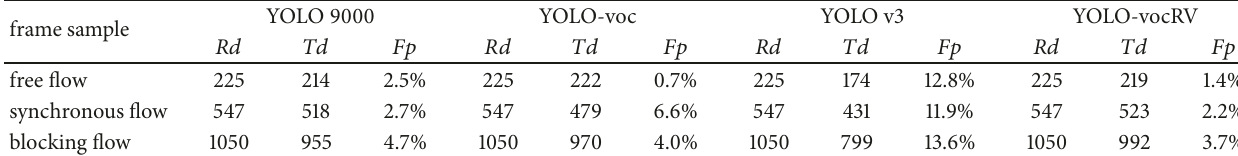
Table 3: Statistics of different model results for blocking flow sample